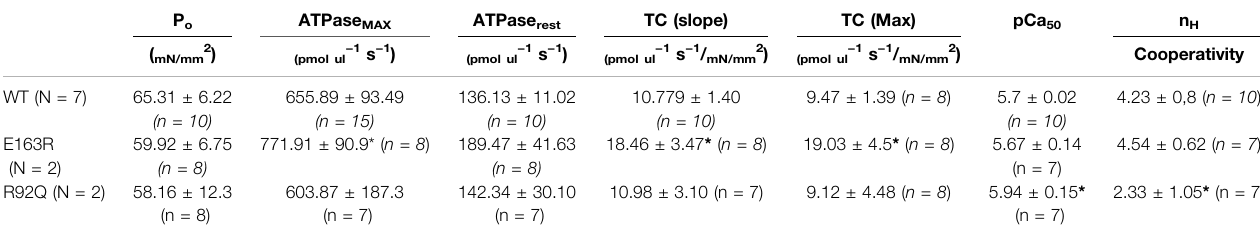
Tensioncost(TC)dataaremeasuredfromATPaseandisometrictensionvaluesmeasuredatmaximalactivation(TCmax)orfromtheslopeoftheATPasetensionrelationshipmeasuredat differentpCa ’ s(TCslope);see Figure3 .Pomaximalisometrictension.pCa 50 , − log10[Ca 2+ ]requiredtogethalfmaximaltension;n H ,Hillcoef fi cient.Statisticaltest:one-wayANOVAwith Tukey correction ( ” * ” indicates a statistically signi fi cant